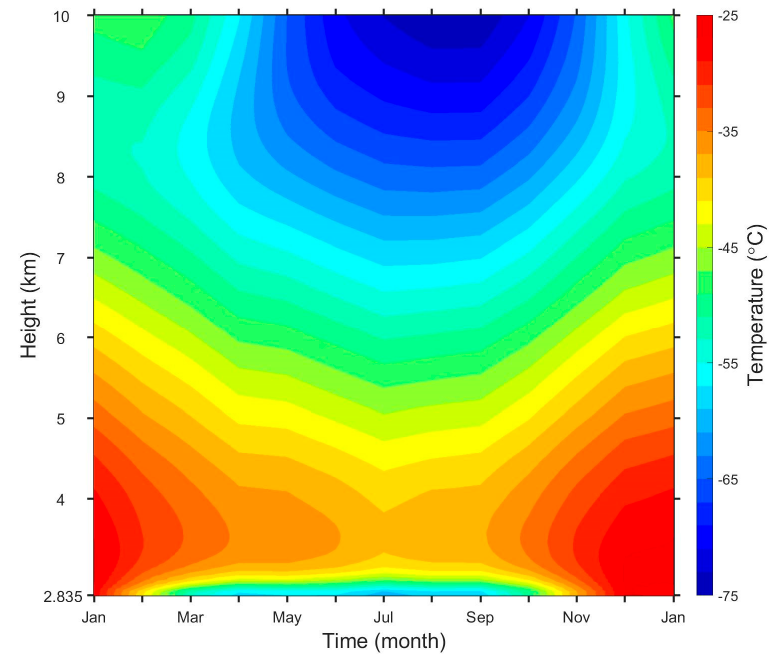
Figure 1. Mean annual cycle of temperature at each height level up to 10 km during 2005 – 2018.